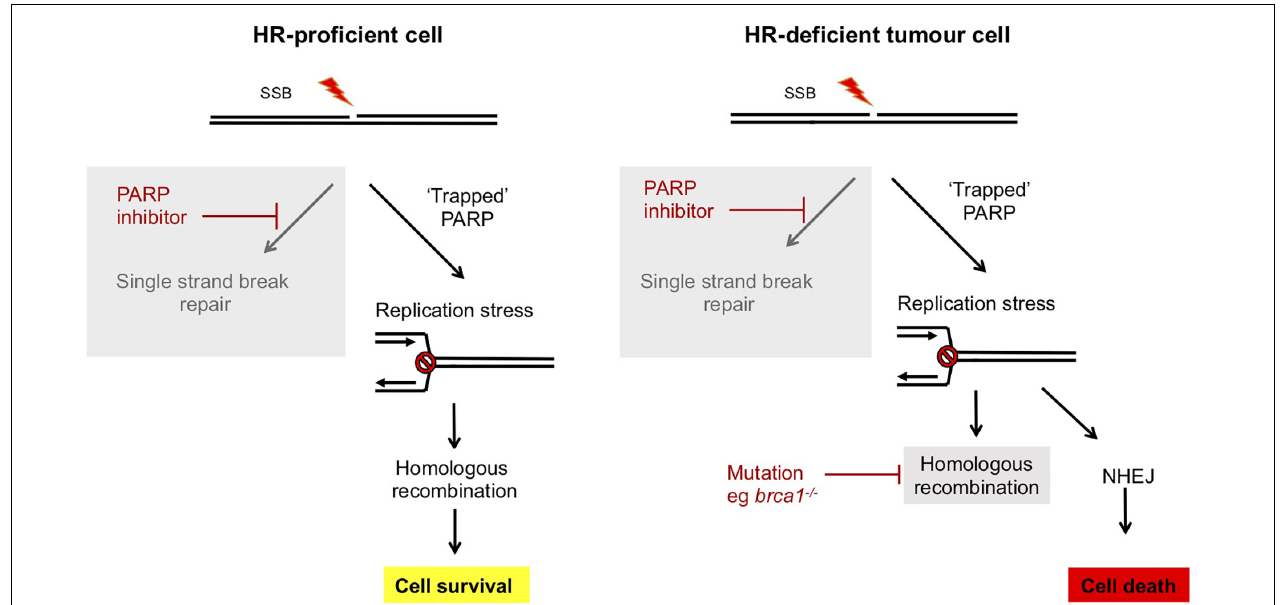
FIGURE 3 | Synthetic lethality of PARP inhibitors in treatment of breast and ovarian cancers deficient in BRCA1/2. In normal human cells, single strand breaks are repaired by PARP-dependent SSBR. In the presence of ART inhibitors PARP is trapped at the lesion and this impedes DNA replication. However, this replication stress can be repaired by an HR dependent mechanism and cells survive. However, in tumor cells which are deficient in components of HR, such as brca1/2 − / − breast or ovarian cancers, HR-dependent resolution of replication stress is not possible and instead mutagenic NHEJ pathways prevail. This results in selective killing of tumor cells by PARP inhibitors (Bryant et al., 2005; Farmer et al., 2005; Slade, 2020).